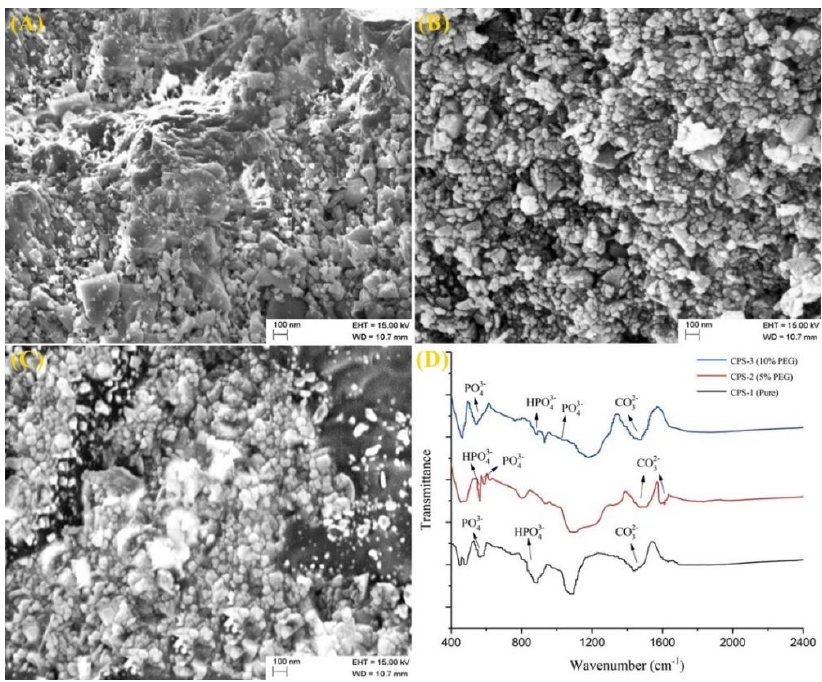
Figure 6. SEM analysis of synthetic body fluid (SBF)-treated CPS-1 ( A ), CPS-2 ( B ), CPS-3 ( C ) and FTIR analysis ( D ).